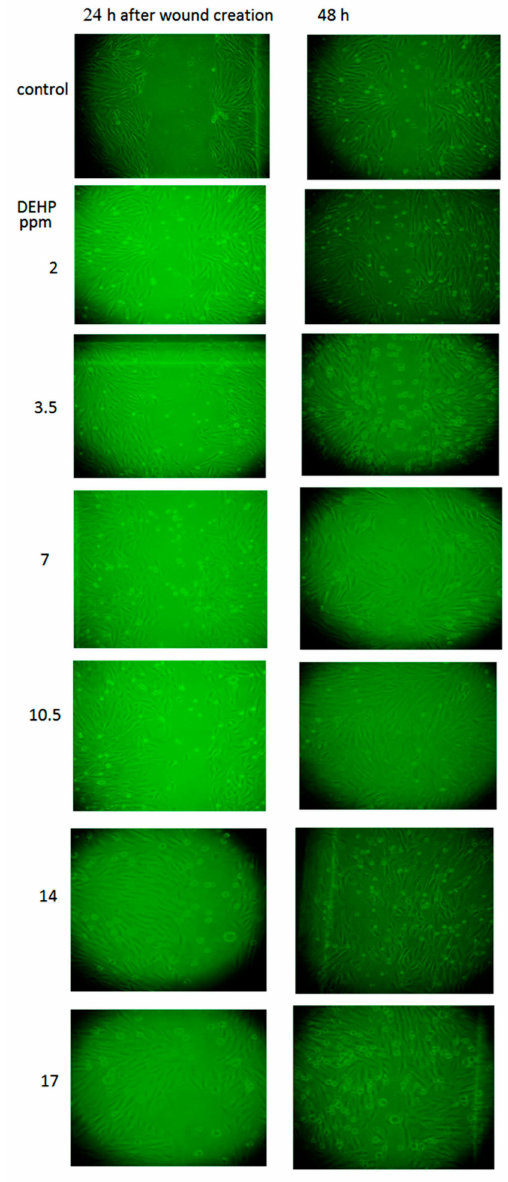
Figure 6. Effects of DEHP on cell migration. VSMC ( n ě 3) were treated with DEHP (between 2 and 17.5 ppm) after the wound being created. Cell migration was observed under a light microscope (200 ˆ ) at 24 h and 48 h after initial wound creation.